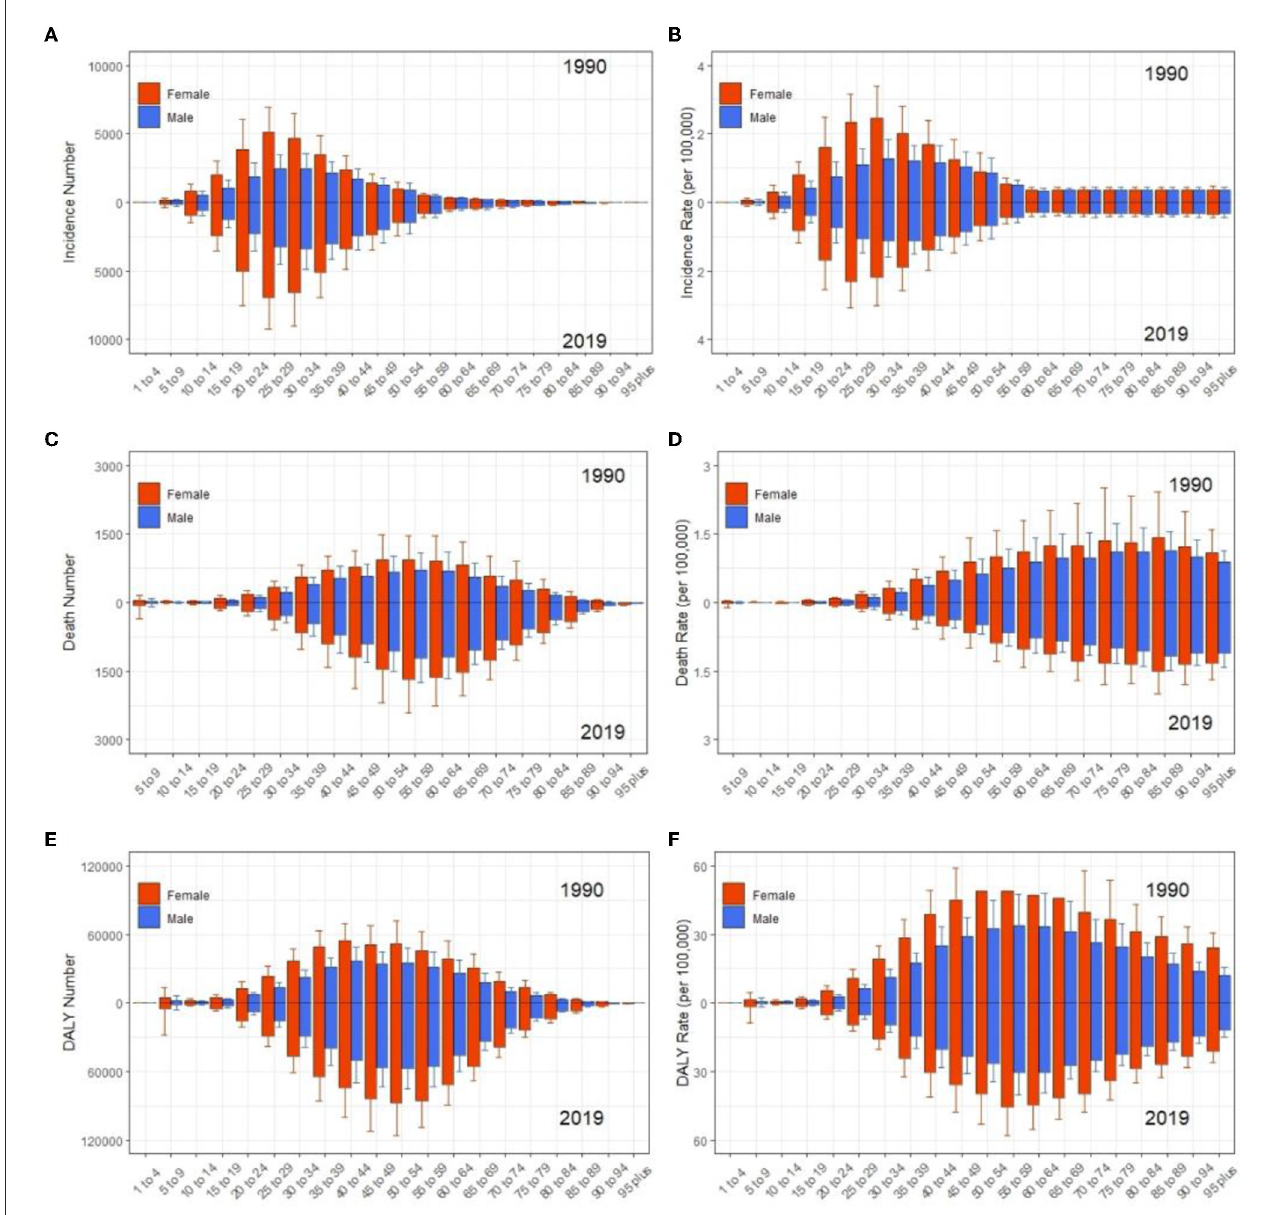
FIGURE2 Comparison of age trends between women and men in incidence (A, B) , deaths (C, D) , and DALYs (E, F) number and rate of MS globally from 1990 to 2019, respectively. Error bars represented the 95% confidence intervals. DALYs, disability-adjusted life years.